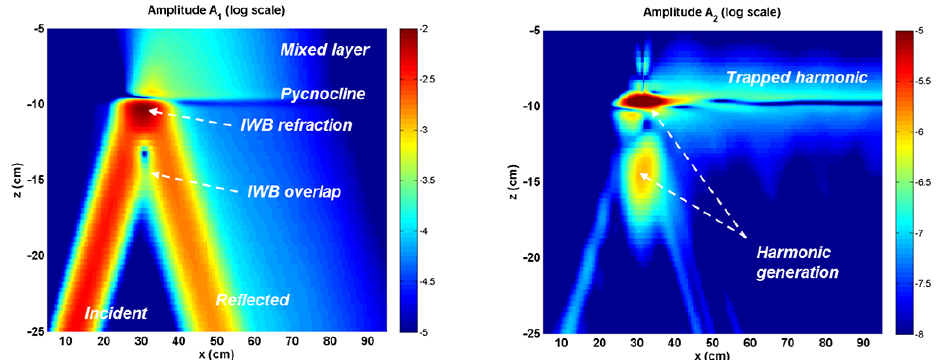
Figure 5. Kinetic energy amplitude in the incident frequency ( ω f , left) and lowest harmonic (2 ω f , right) bands for the simulation with θ = 40 degrees and r = 4, illustrating the trapped harmonic mode.